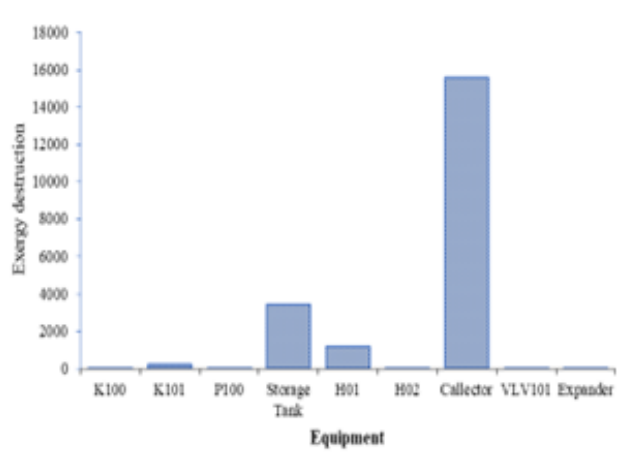
Figure 5 Exergy destruction of all equipment